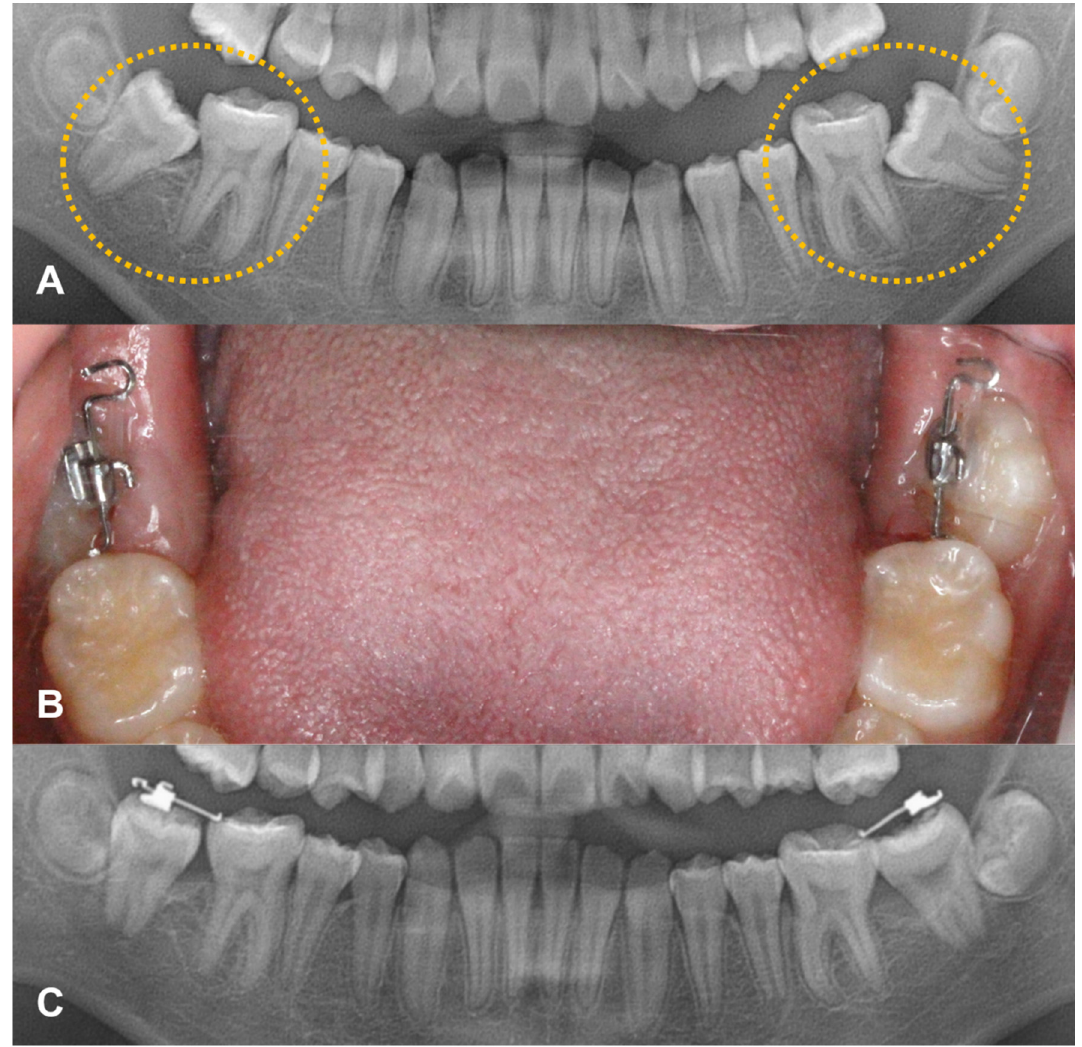
Figure 3. Case of second molar uprighting. ( A ) A 12-year-old-girl shows the mesially angulated impaction of lower second molars bilaterally. ( B ) Piston-elastic devices were attached ( C ) After three months, the directions of lower second molars were improved.